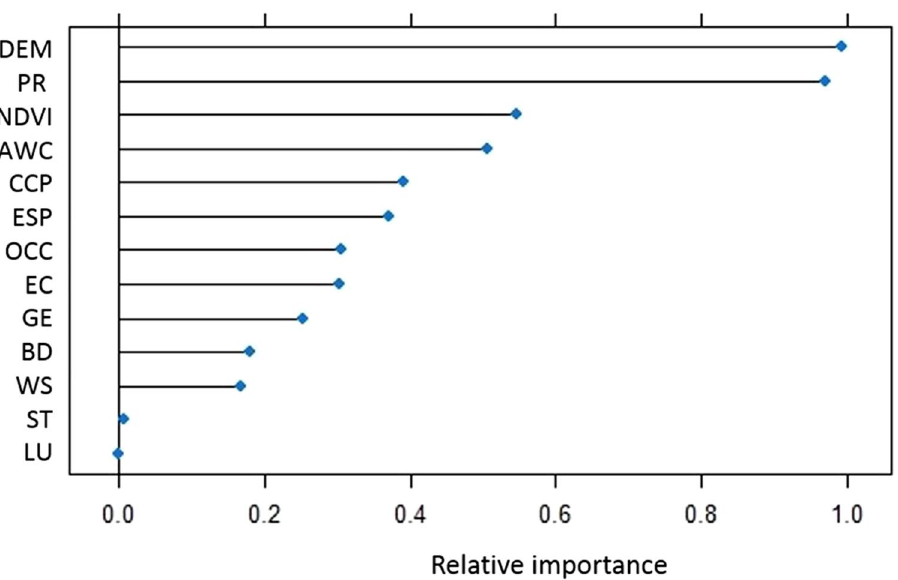
Figure 1. The relative importance of the effective factors for wind erosion estimated by MMLPNN. DEM, PR, NDVI, AWC, CCP, ESP, OCC, EC, GE, BD, WS, ST, and LU indicate digital elevation model, precipitation, normalized difference vegetation index, available water content, calcium carbonate content, exchangeable sodium percentage, organic carbon content, electrical conductivity, geology, bulk density, wind speed, soil texture, and land use,